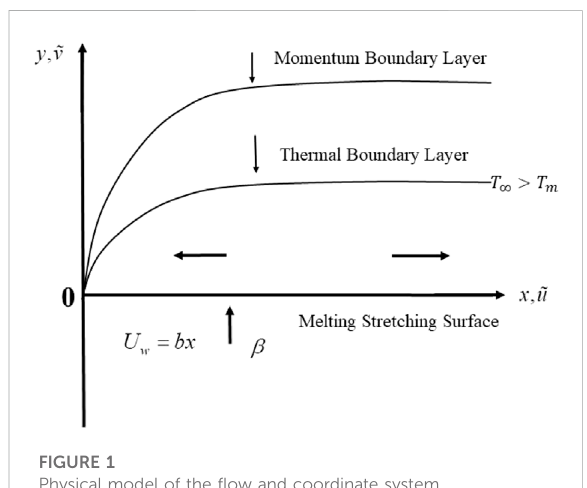
FIGURE 1 Physical model of the fl ow and coordinate system.